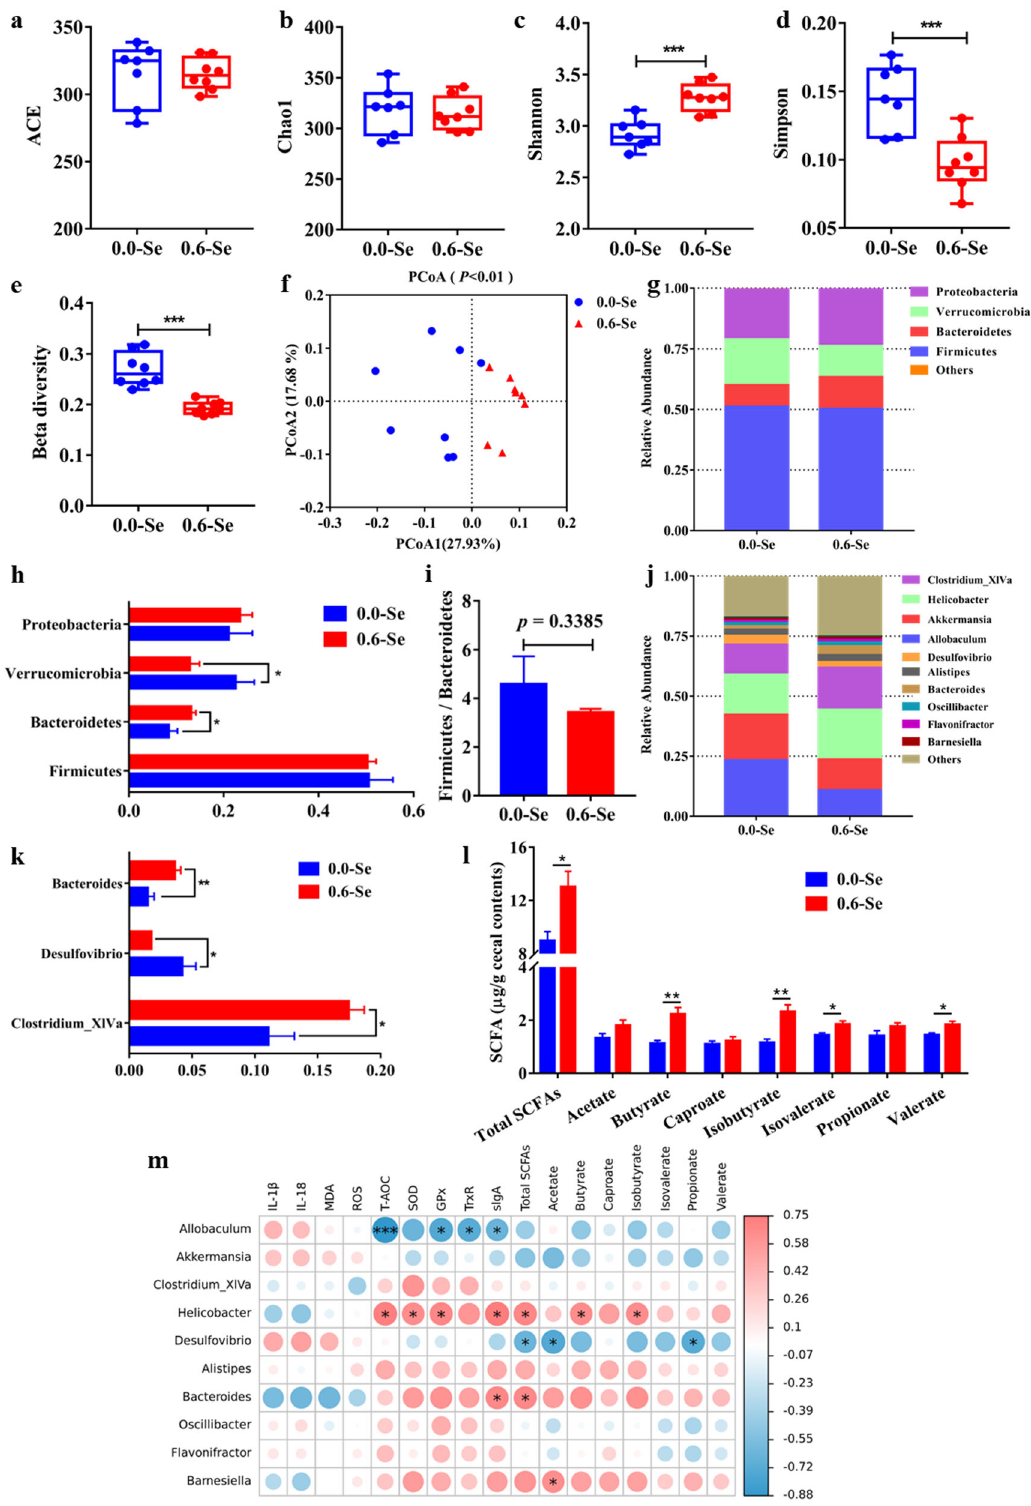
Fig. 5 Effects of different dietary SeNPs supplementation on gut microbiota and SCFAs levels of mice. a – d Alpha diversity index ( n ≥ 7). e Beta diversity index ( n ≥ 7). f PCoA ( n ≥ 7). g The relative abundance composition of fecal microbiota at the phylum level ( n ≥ 7). h Differences in fecal microbiota between the phylum level ( n ≥ 7). i Ratio of Firmicutes to Bacteroides ( n ≥ 7). j The relative abundance composition of fecal microbiota at the genus level ( n ≥ 7). k Differences in fecal microbiota between the genus level ( n ≥ 7). l SCFAs levels in the cecal contents of mice ( n = 5). m Heatmap of Spearman ’ s correlation between the abundance of gut microbiota and the intestinal barrier dysfunction-related biochemical indexes. Data are expressed as mean ± SEM. * P < 0.05; ** P < 0.01; *** P <